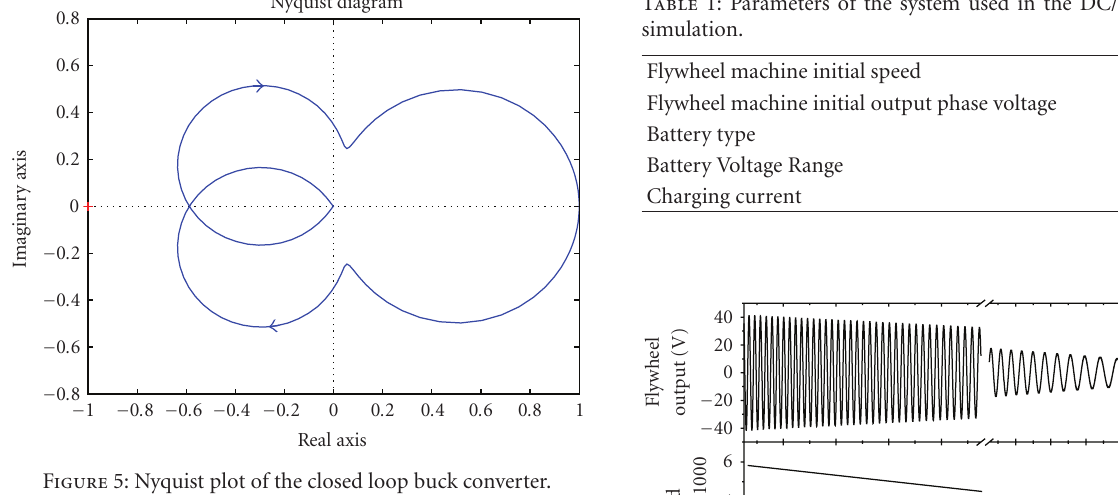
Figure 5: Nyquist plot of the closed loop buck converter.